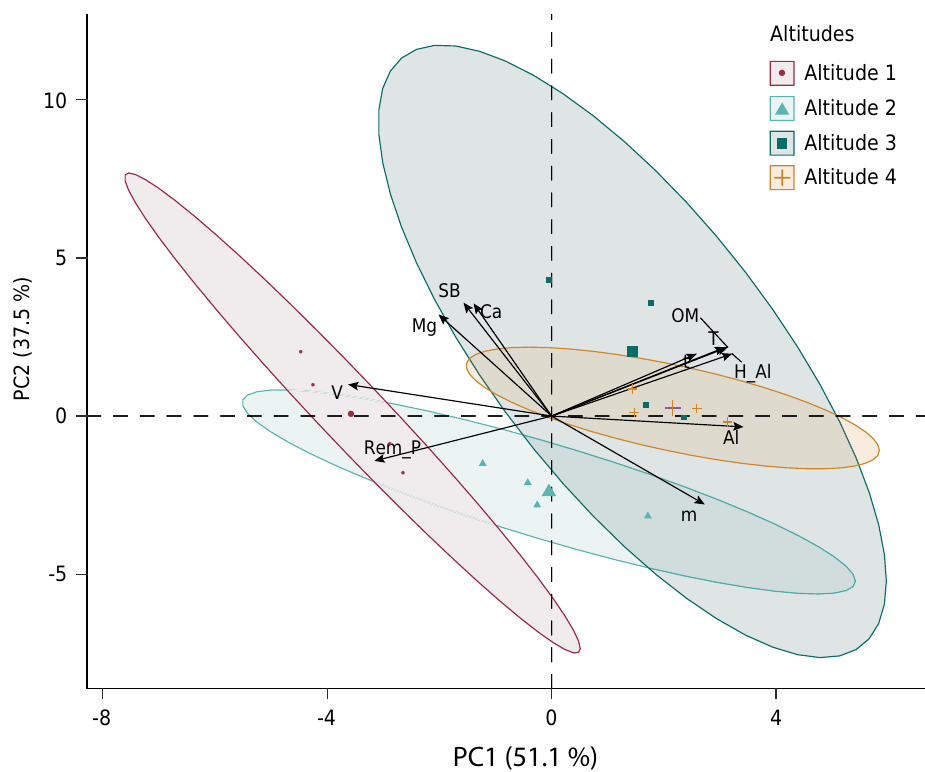
Figure 3. Principal component analysis using data for physicochemical soil properties in four different altitudes of the PARNASO. Soil parameters: Mg: magnesium; Ca: calcium; Al: aluminum; m: aluminum saturation index; H+Al: exchangeable acidity; Rem_P: remaining phosphorus; OM: organic matter; SB: sum of exchangeable bases; T: cation exchange capacity at pH 7.